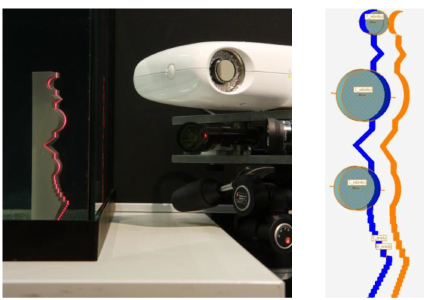
Figure 8. Laboratory setup for an underwater measurement of a contour artefact (left) and result (3D point cloud) - orange: not corrected; blue: corrected with multi- media approach (right)